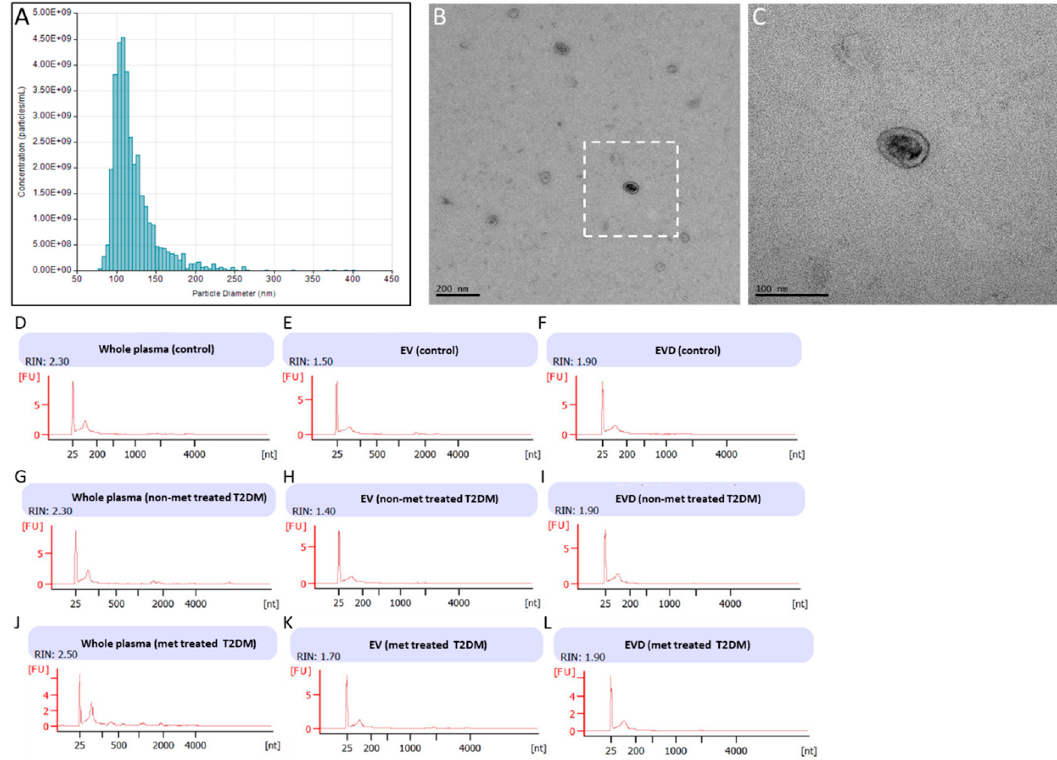
Figure 1. Isolation and characterization of extracellular vesicles (EVs) and RNA from plasma. ( A ) Histogram of EV isolated from plasma ( B , C ) EV imaged using TEM ( D – J ) bioanalyzer traces from whole plasma, EV, and EV-depleted (EVD) samples. ( A ) Histogram generated by qNano particle tracker of EVs isolated using SEC from patient plasma samples, with an average particle size of 122 nm. ( B ) Electron micrographs taken from isolated EVs, showing particles of a similar size that have characteristic shape and form of EVs. Black bar represents 200 nm scale. ( C ) Enlargement of boxed in area in ( B ). Black bar represents 100 nm scale. ( D – L ) Agilent RNA bioanalyzer traces of RNA isolated from control plasma ( D ), control EVs ( E ), control EVD ( F ), non-metformin (non-met) treated T2DM plasma ( G ), non-metformin treated type 2 diabetes mellitus (T2DM) EVs ( H ), non-metformin treated T2DM EVD ( I ), metformin (met) treated T2DM plasma ( J ), metformin treated T2DM EVs ( K ), and metformin treated T2DM EVD ( L